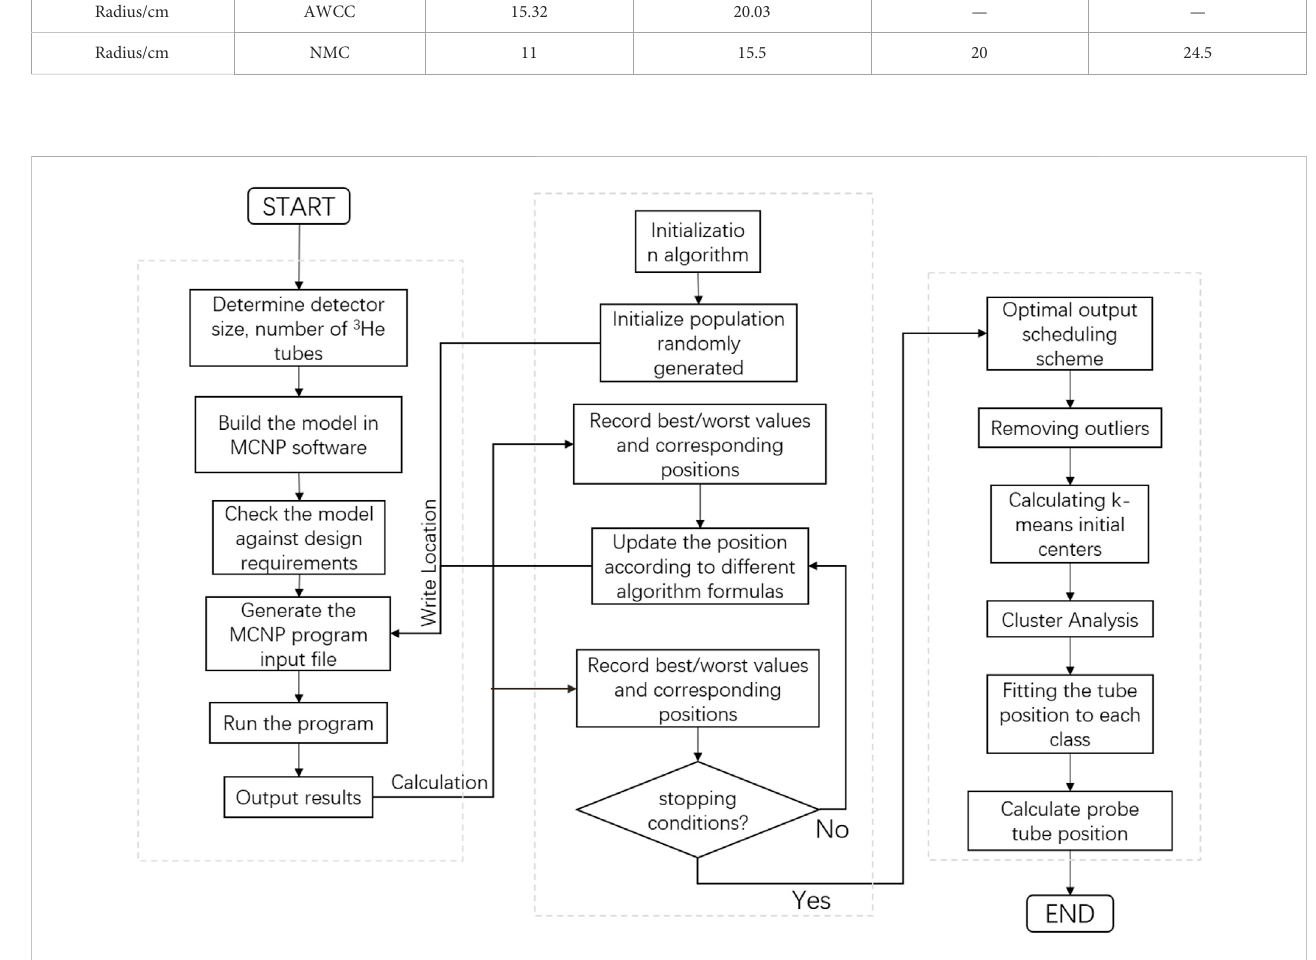
FIGURE 2 Flow chart of the general technical